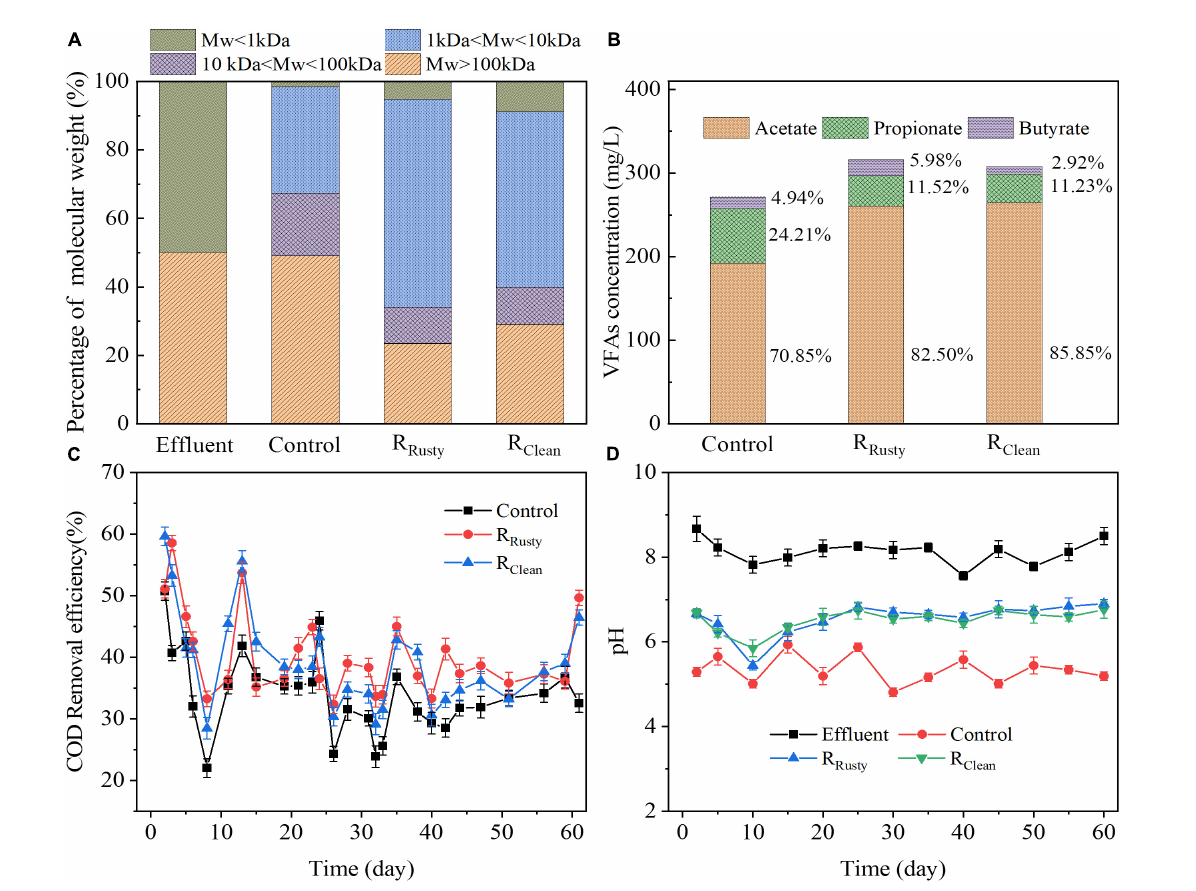
FIGURE1 HA performance: (A) distribution of molecular weight; (B) VFAs concentration; and (C) COD removal, and (D) pH values in control, R Rusty , and R Clean